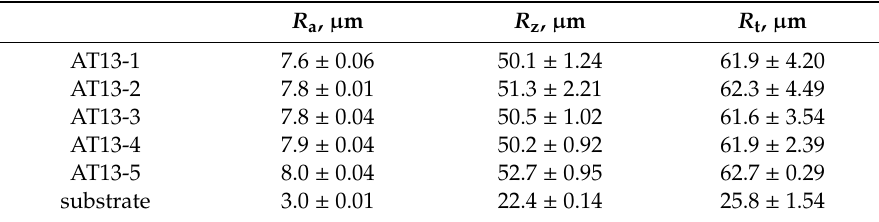
Table 2. Mean values of coatings roughness.